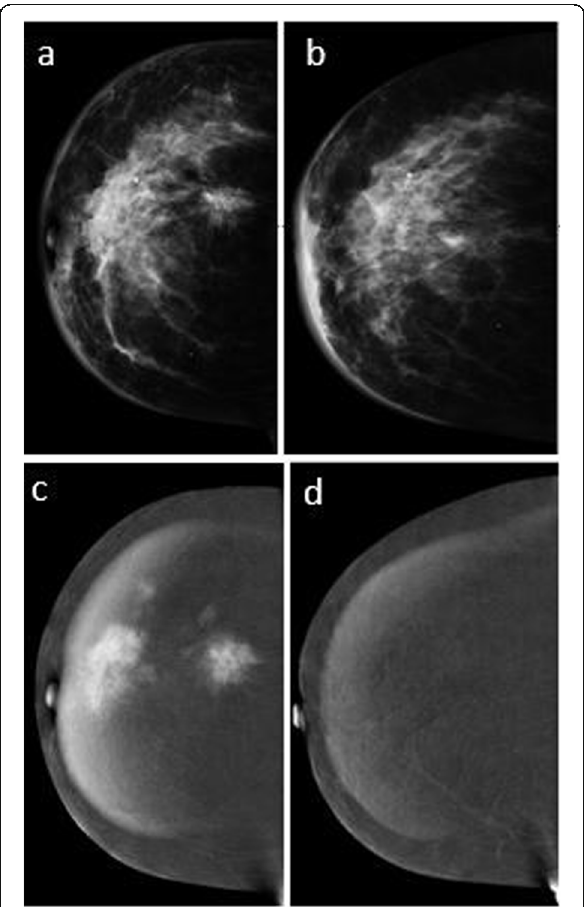
Fig. 5 a Pre-NAC mammogram; spiculated LIQ mass. b Post-NAC mammogram; no change in size. c Pre-NAC CESM; lesions. d Post- NAC CESM; decreased enhancement without size change. Both RECI ST 1.1 and combined response evaluation; non-responder. Pathology; Miller-Payne grade 1